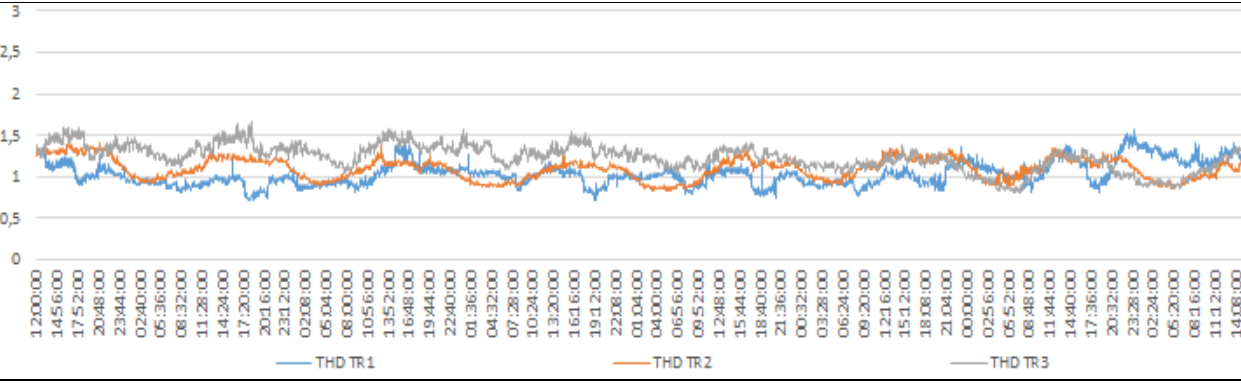
Figure 5: THD voltage phase “a” indicator